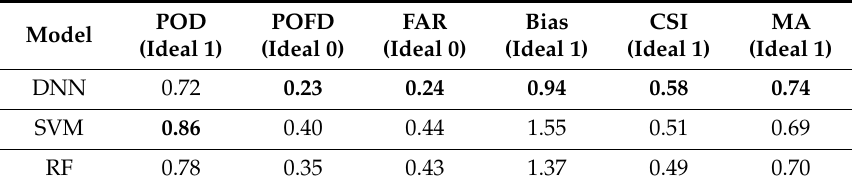
Table 6. Validation of convective precipitation delineation model on testing data. The best result for each assessor is shown in